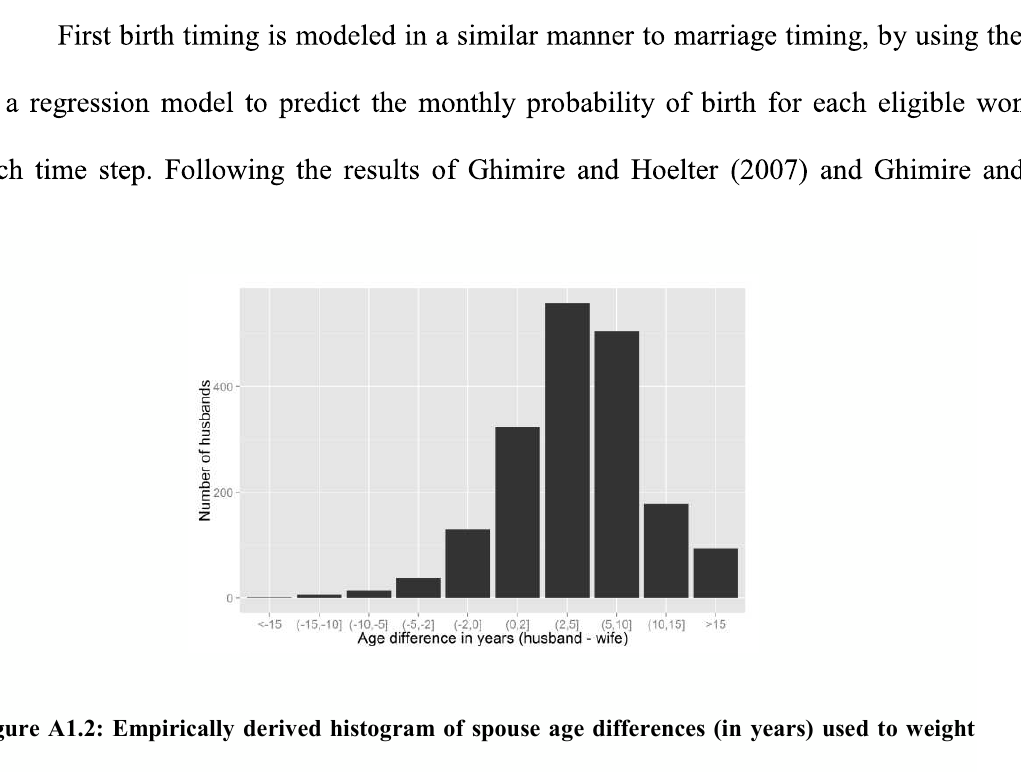
Figure A1.2: Empirically derived histogram of spouse age differences (in years) used to weight the probability of a given person agent marrying a particular potential